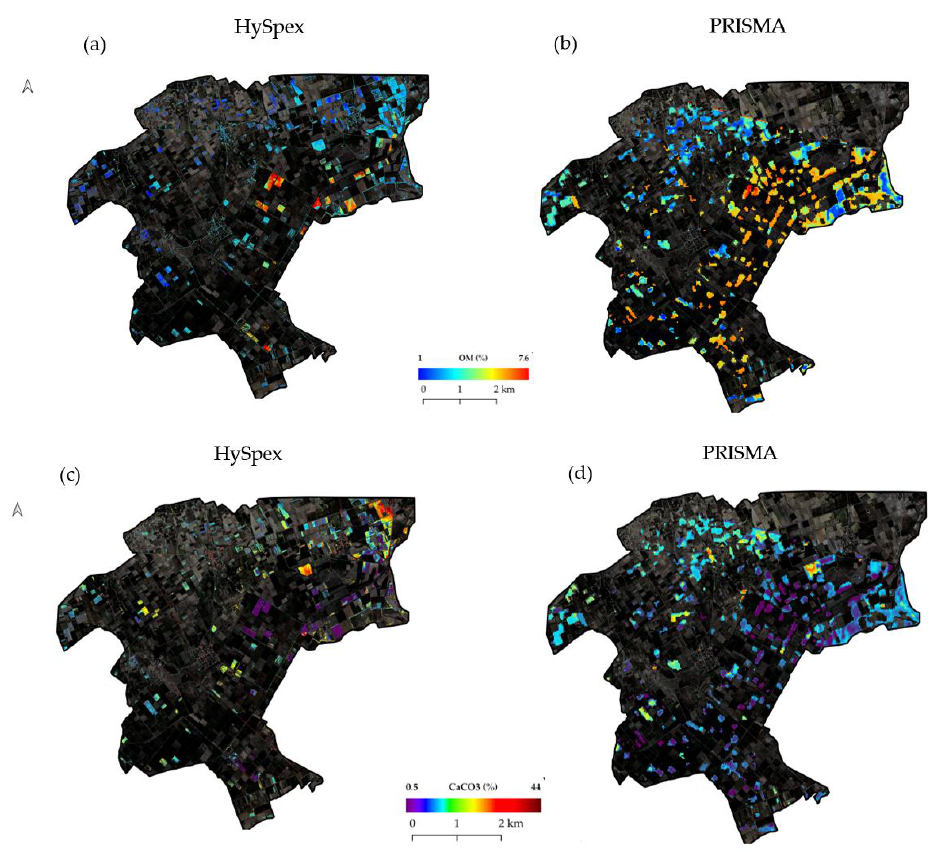
Figure 22. Prediction maps obtained from the best fitted models ( a , b ) for SOM, and ( c , d ) for CaCO 3